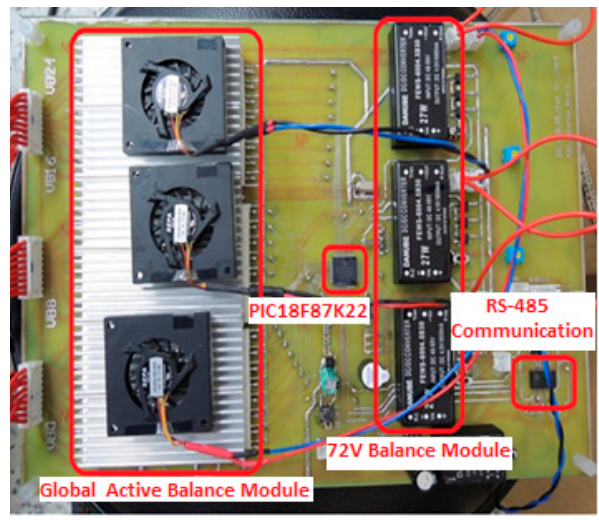
Figure 7. 72 V balance module.